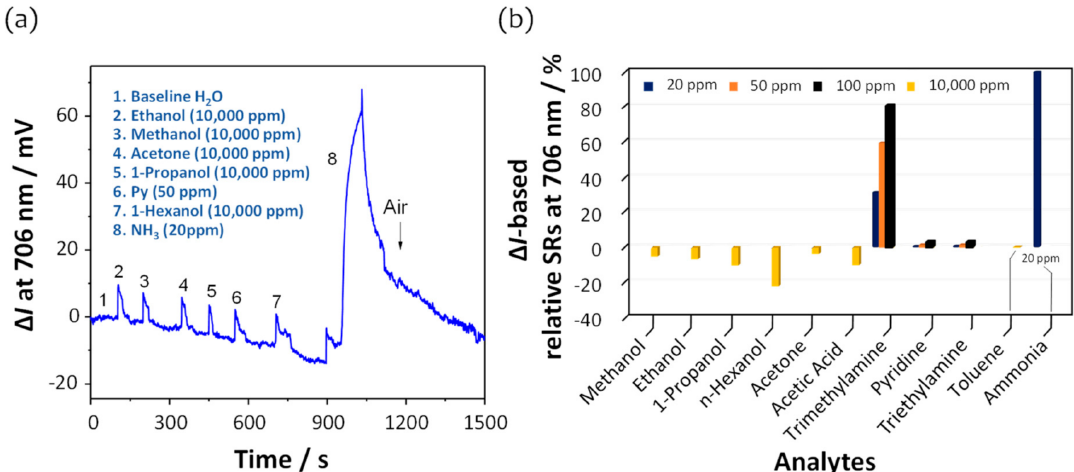
Figure 6. ( a ) Dynamic response to ammonia and other chemical analytes. ( b ) Comparison of the intensity change-based relative SRs at 706 nm on exposure to ammonia (20 ppm), TMA, TEA, Py (20 ppm, 50 ppm, 100 ppm, respectively), and all other analytes at 10,000 ppm.